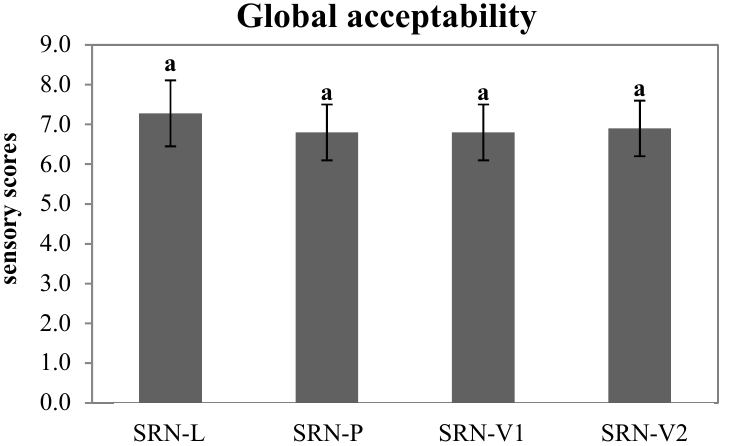
Figure 6. Global acceptability of the baked SRNs prepared with the different fat blends, L, P, V1, and V2. The same letters correspond to no statistically significant differences ( p ≤ 0.05).